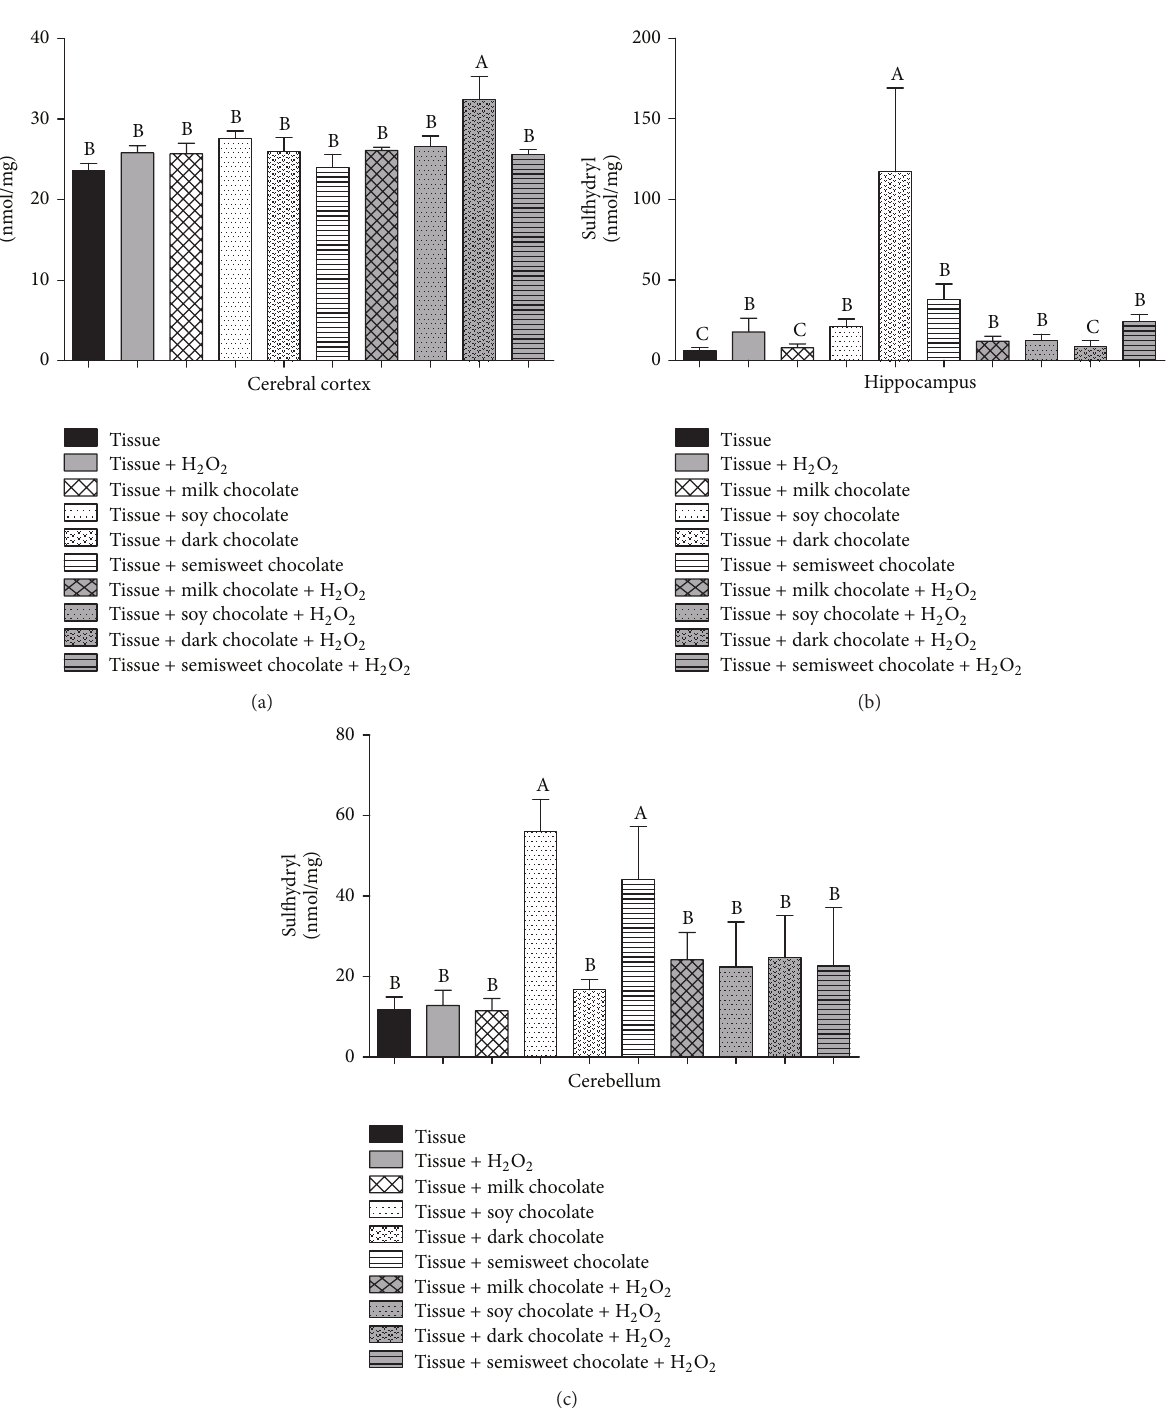
Figure 3: Antioxidant activity by sulfhydryl groups in cerebral cortex (a), hippocampus (b), and cerebellum (c) of Wistar rats treated with different chocolate types with or without hydrogen peroxide. Different letters show statistical difference between them ( 𝑝 < 0.05